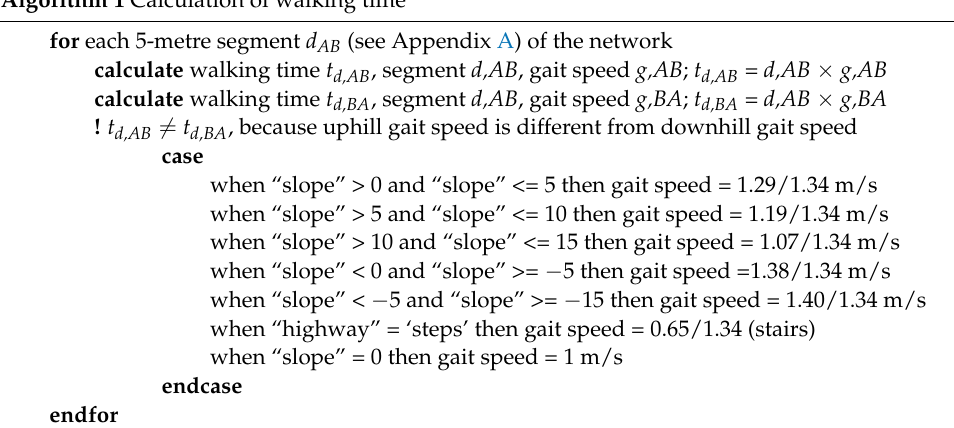
Algorithm 1 Calculation of walking time